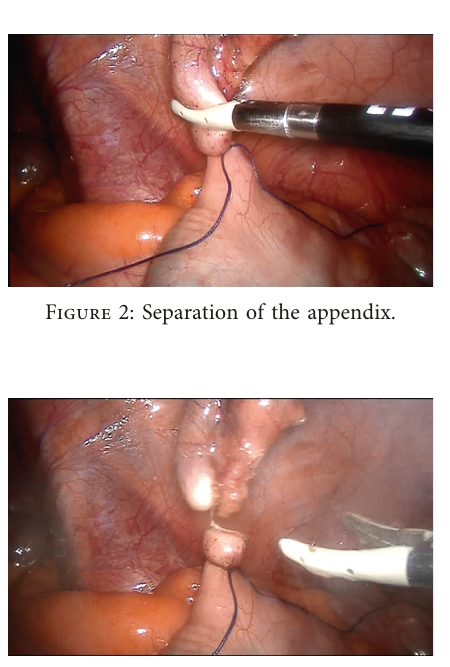
Figure 3: View of the residual appendix.